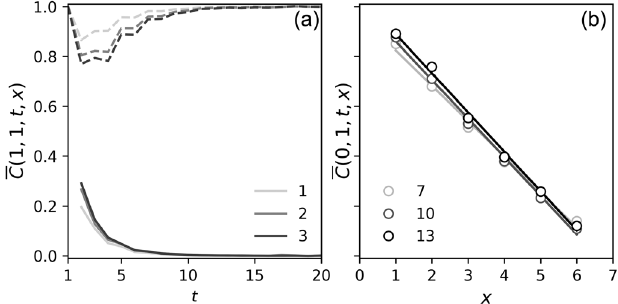
¯ C ð s ; s ; t; x Þ between the space-time- FIG. 17. Correlations L R local pairings of orbits in a system of L ¼ 8 sites, with (a) a particular domain and (b) a domain wall imposed by the boundary conditions. In panel (a) the dashed lines correspond to s L ¼ s R ¼ 0 , and the solid lines correspond to s L ¼ s R ¼ 1 . The site x is shown on the legend. In panel (b), s L ¼ 0 and s ¼ 1 , and the correlations are shown as a function of position x . R The different sets of points correspond to different times t , shown on the legend, and the lines are linear fits to the